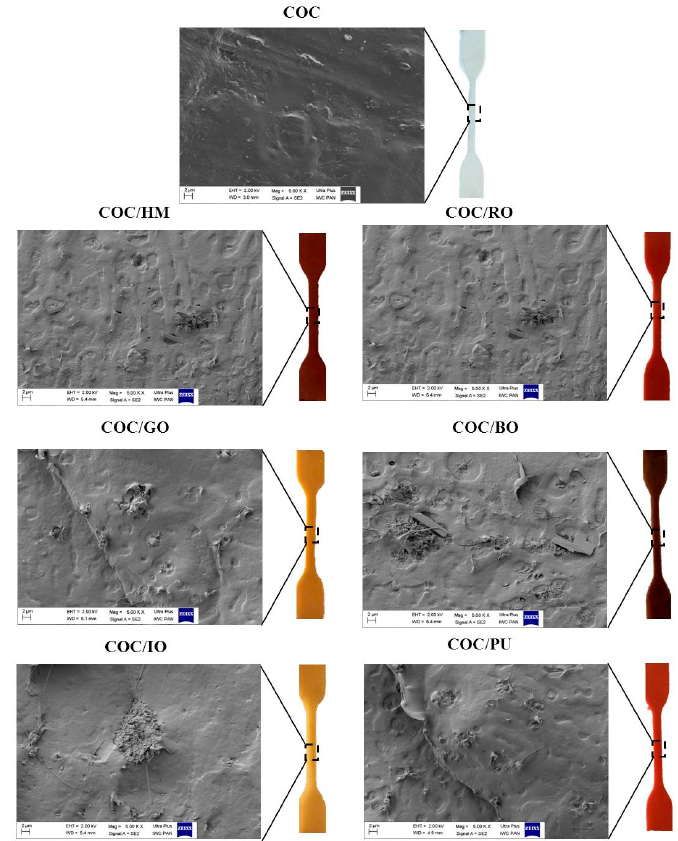
Figure 6. Scanning electron microscopy (SEM) images and digital photographs of the COC copolymer containing earth pigments.